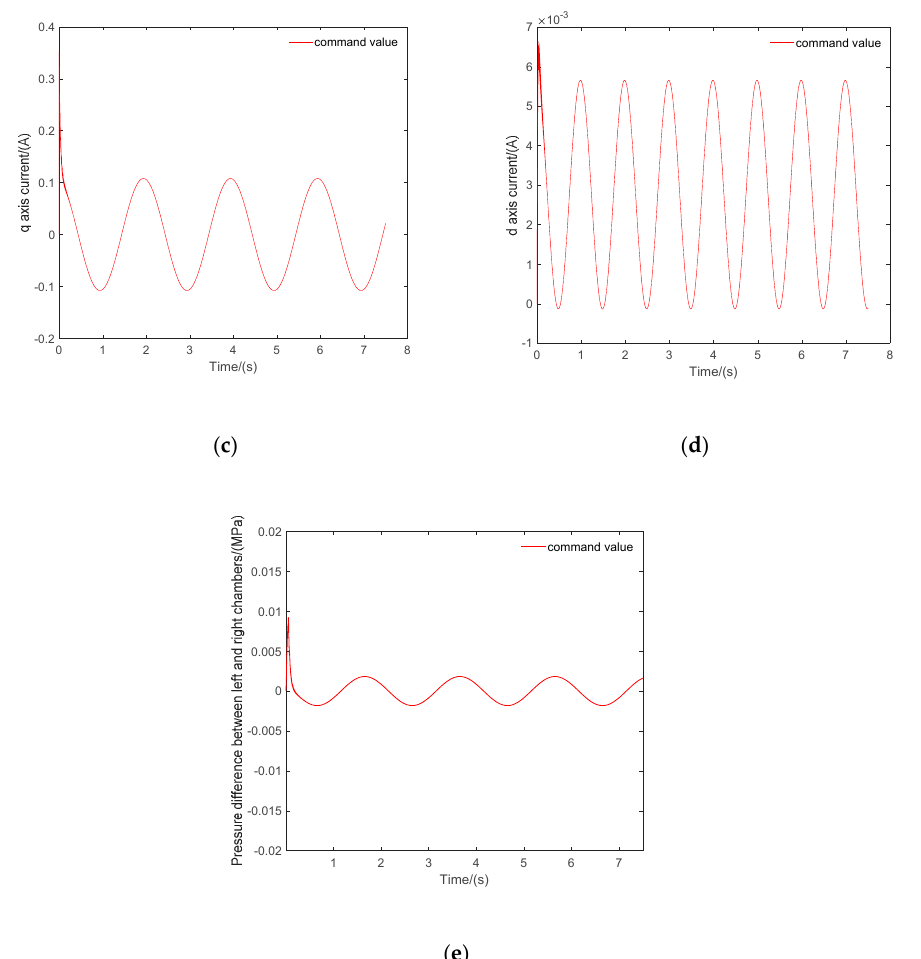
Figure 8. MATLAB/Simulink simulation diagram under 2.5-degree 0.5 Hz sinusoidal signal. ( a ) An- gle comparison; ( b ) Motor speed comparison; ( c ) q axis current; ( d ) d axis current; ( e ) Pressure difference between the left and right chambers of the hydraulic cylinder.